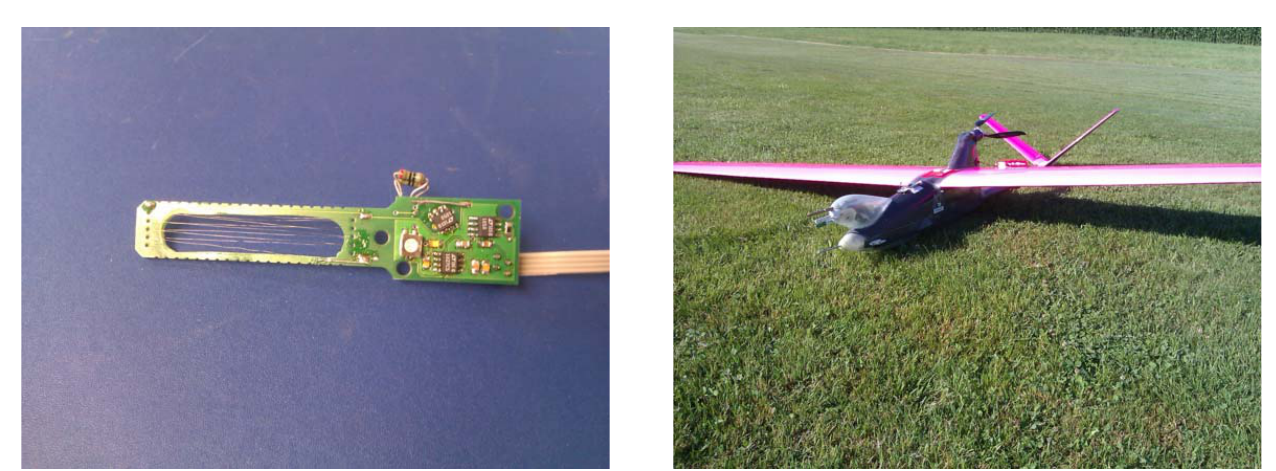
Fig. 5. Fine wire platinum resistance thermometer with 25µm wire. The flow direction is from the left.